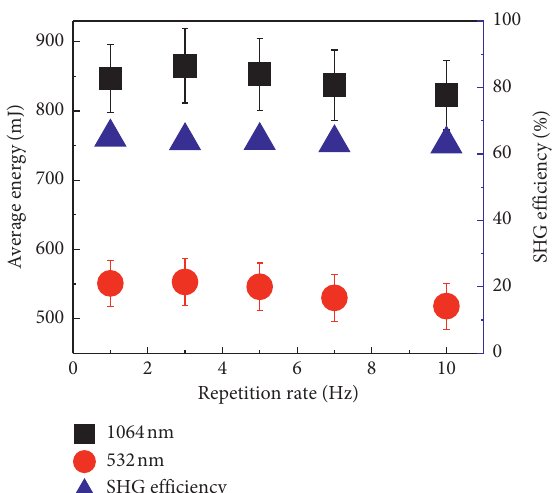
Figure 5: The average energy of 1064nm and 532nm laser and SHG Efficiency under different repetition rates.